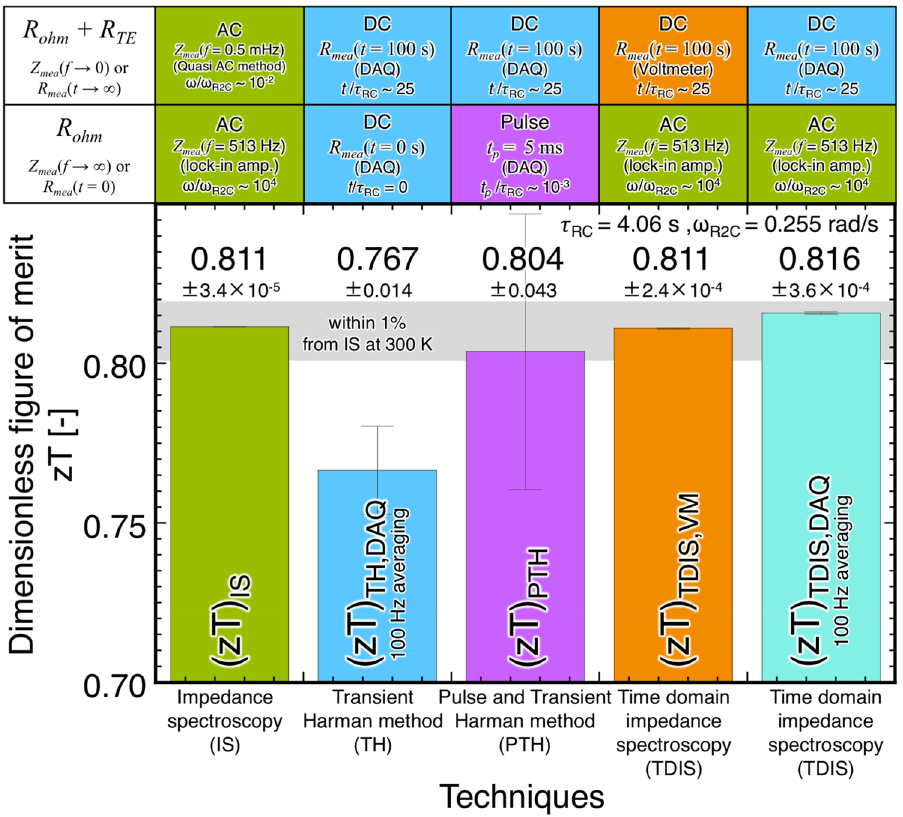
Figure 7. A summary of zT of the prepared TM estimated by various techniques, devices used, and conditions for R ohm and R ohm + R TE at 300.000